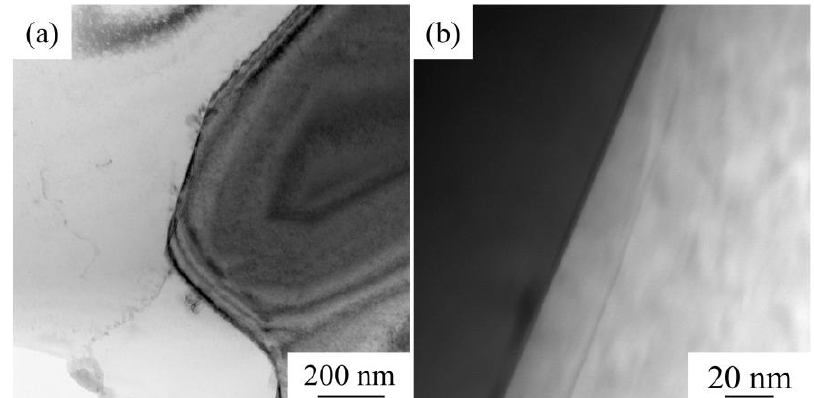
Figure 9. TEM images of sintered 25 vol.% AlN/Al composite: ( a ) low magnification image, where the Al matrix is white and AlN particles are black; ( b ) high magnification image, where the Al matrix is black and AlN particles are white.